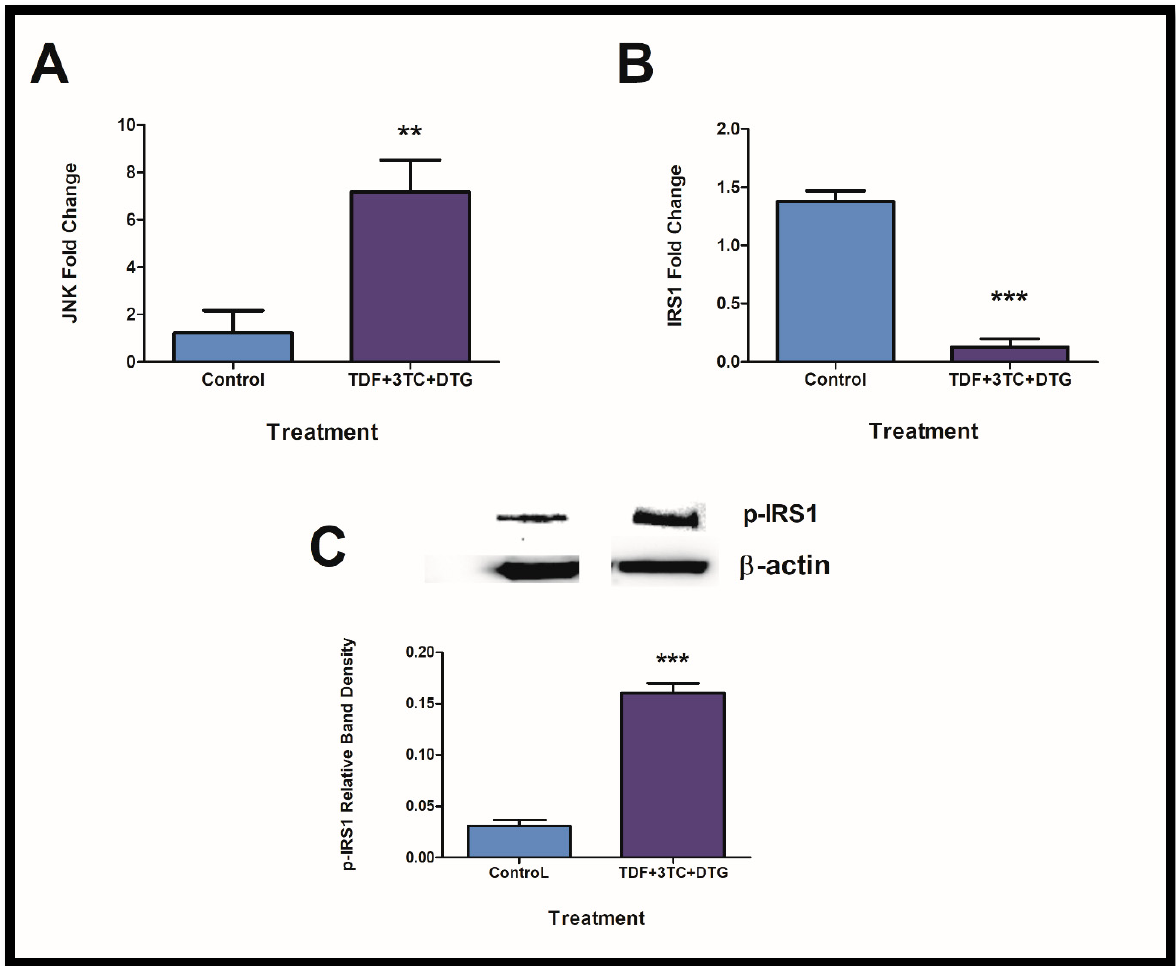
Figure 2. ARVs interfere with insulin receptor expressions via JNK. JNK expression was significantly increased (( A ); ** p < 0.005) whereas IRS1 expressions showed suppression (( B ); *** p < 0.0001). Fur- thermore, phosphorylated IRS1 protein expression showed significant elevations (( C ); *** p < 0.0001). Bands for protein expression of p-IRS1 and β -actin were obtained from the same membrane.